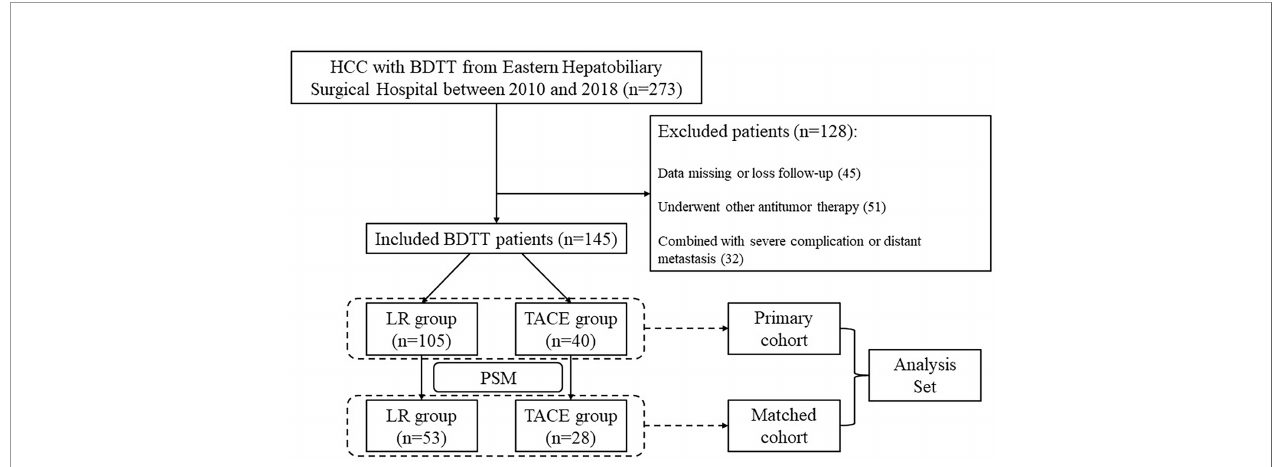
FIGURE 1 | Flowchart to select eligible HCC patients with BDTT for the study. HCC, hepatocellular carcinoma; BDTT, bile duct tumor thrombus; LR, liver resection; TACE, transcatheter arterial chemoembolization; RFA, radiofrequency ablation; RT, radiation therapy; PSM, propensity score